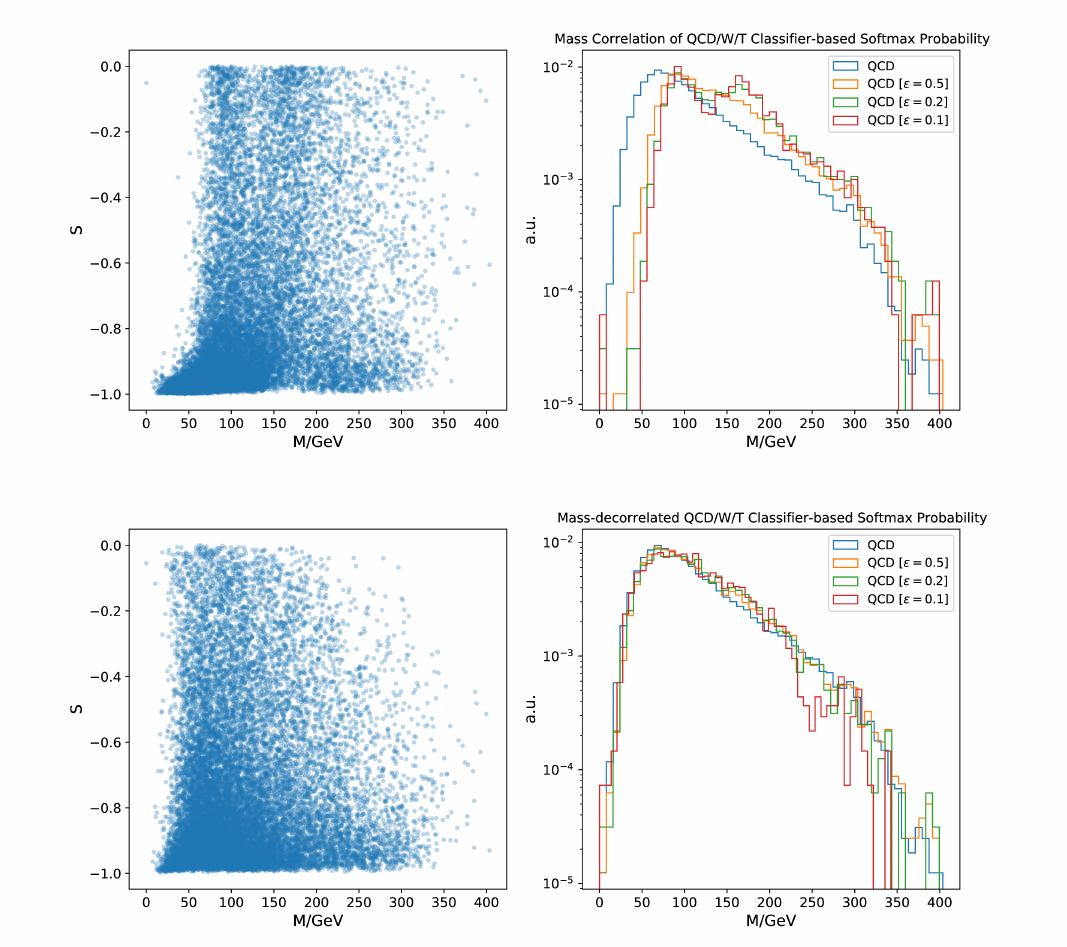
Figure 6 . Top : The un-decorrelated model with p QCD as the anomaly score. Bottom : The mass- decorrelated model with p QCD as the anomaly score. Left : The correlation between jet mass M and the anomaly score. Right : Mass distributions for different background acceptance rates ( (cid:15)